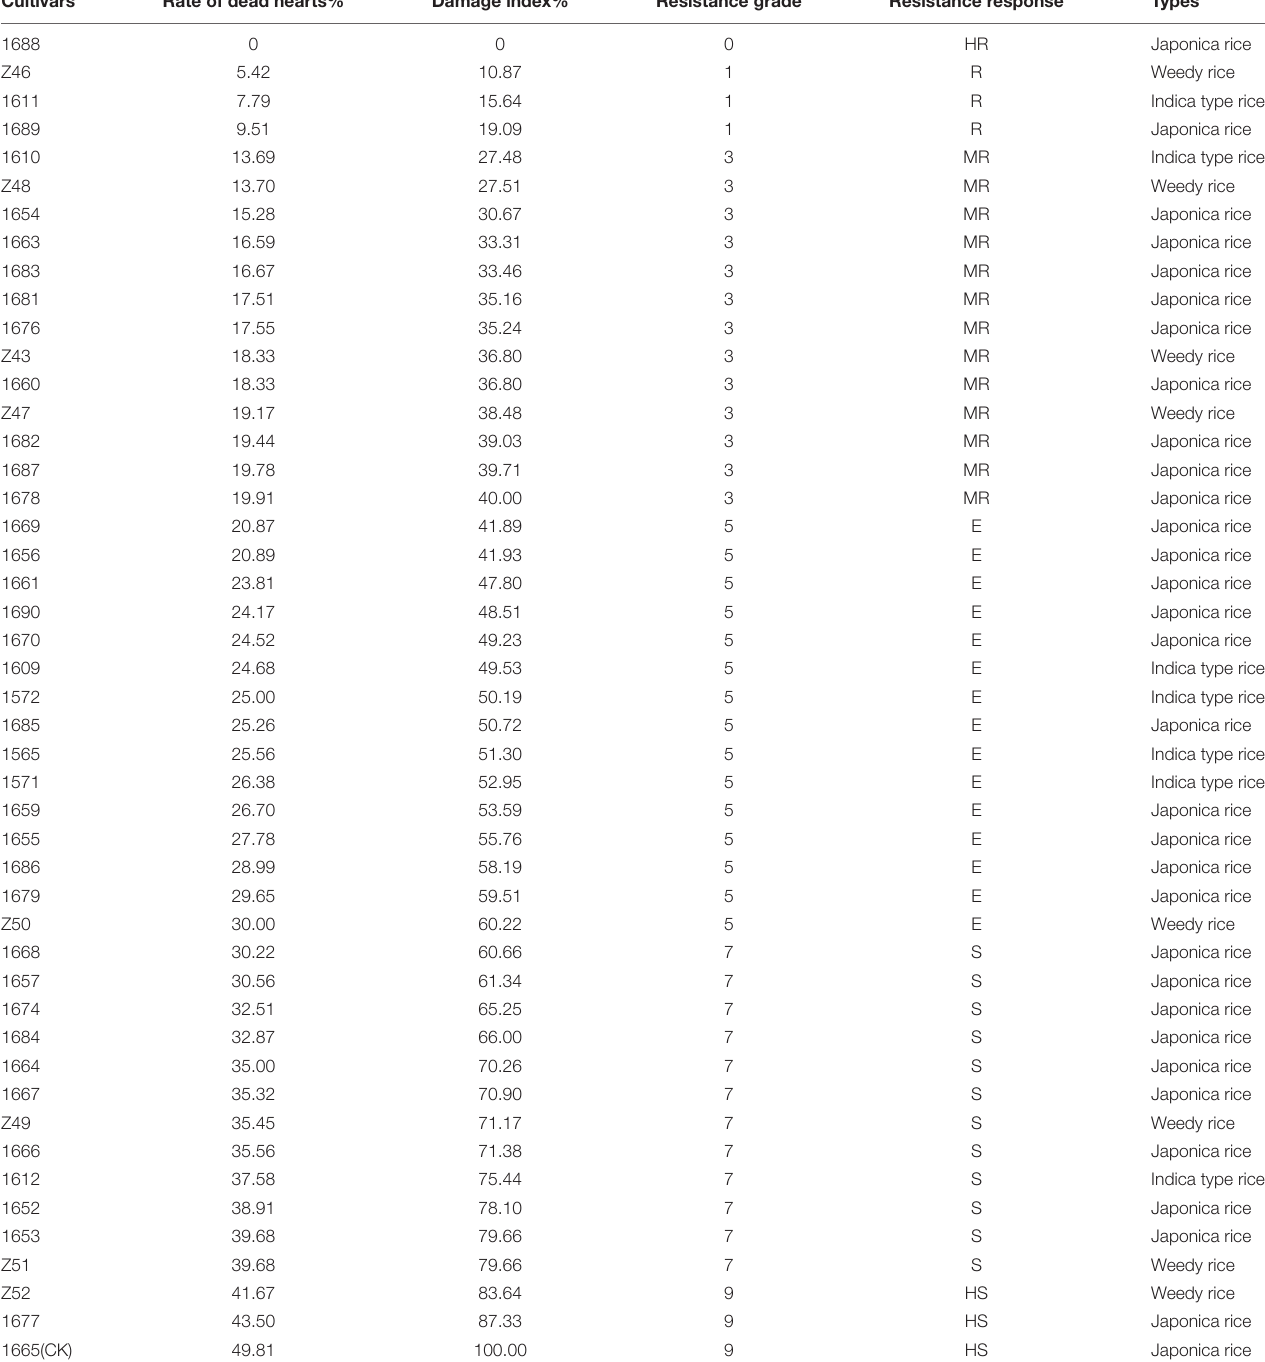
TABLE 3 | Identification results of rice resistance to SSB in field. Cultivars Rate of dead hearts% Damage index% Resistance grade Resistance